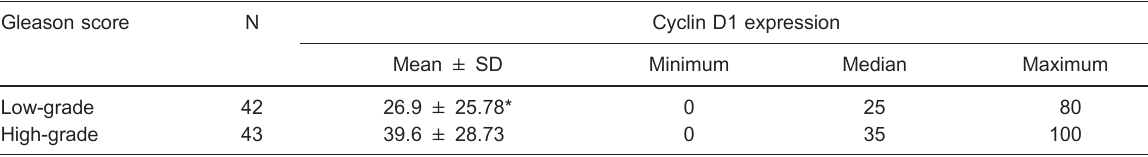
Table 3. Cyclin D1 expression and Gleason score.